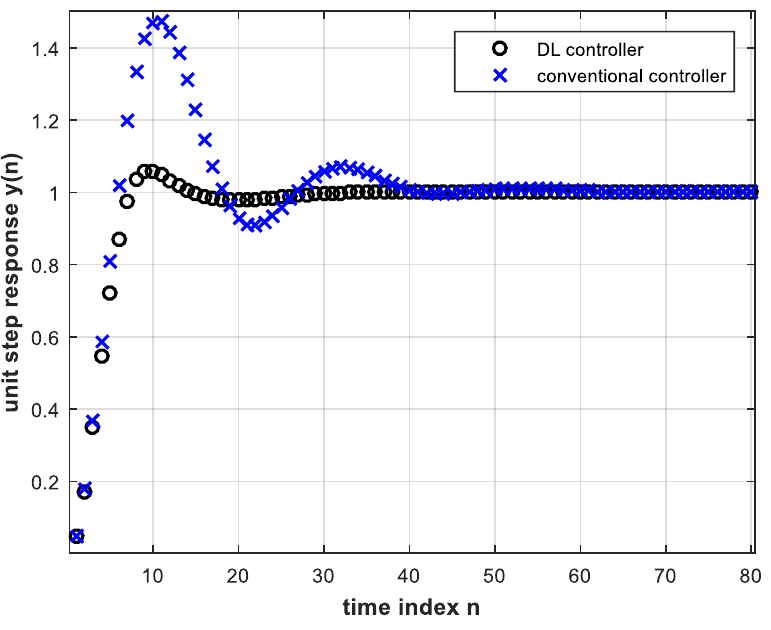
Figure 11. A magnified view of Figure 10. Table 2. Unit step response settling times for different controllers under plant gain change.